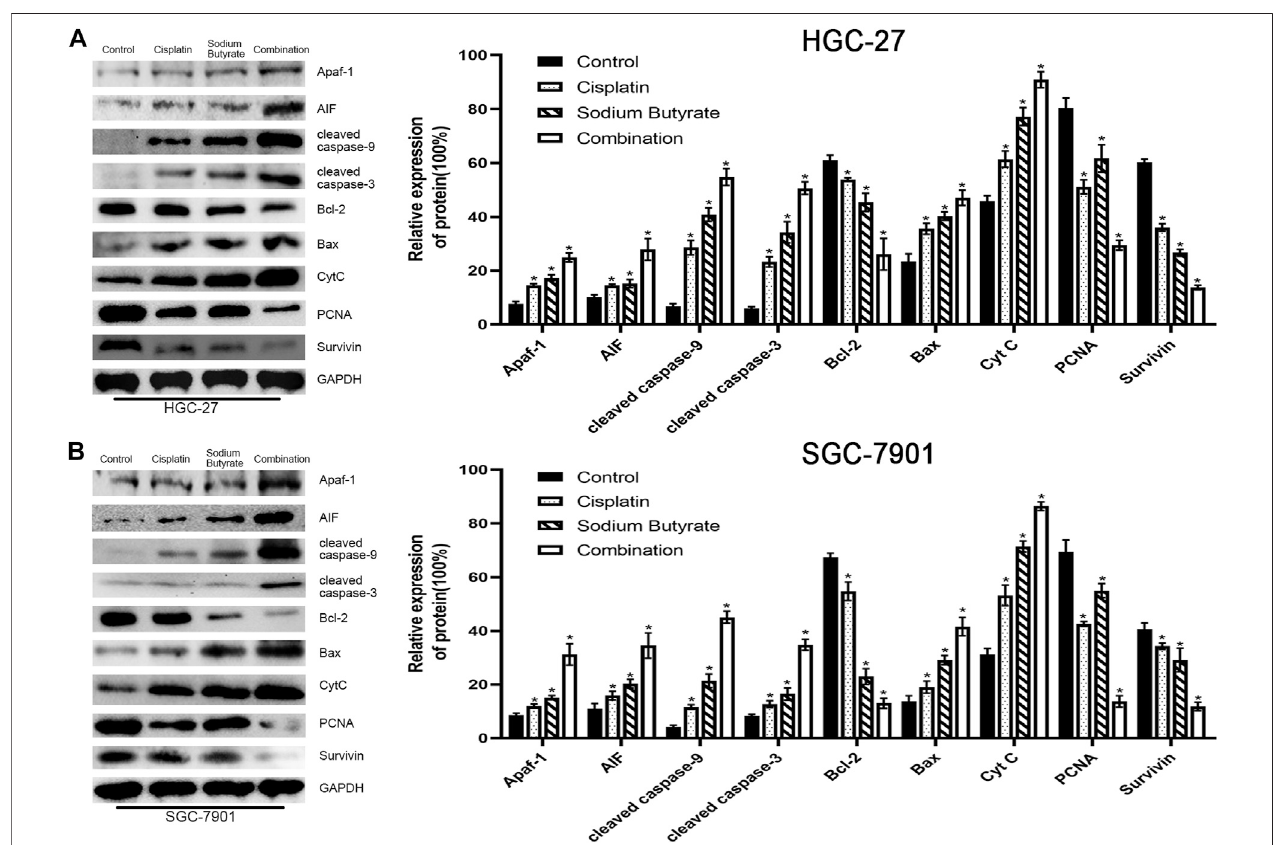
FIGURE 5 | Sodium butyrate combined with cisplatin induces apoptosis through the mitochondrial pathway. (A) HGC-27 cells were treated with control, 4 µg/ml cisplatin,10 mMsodiumbutyrate,or4 µg/mlcisplatin+10 mMsodiumbutyrate,andwesternblottingwasperformedtodetectthelevelsofrelatedproteins.* p < 0.05vs the control group. (B) SGC-7901 cells were treated with control, 4 µg/ml cisplatin, 5 mM sodium butyrate, or 4 µg/ml cisplatin +5 mM sodium butyrate, and western blotting was performed to detect the levels of related proteins. * p < 0.05 vs the control group. All the above data are the mean ± SD from an average of three